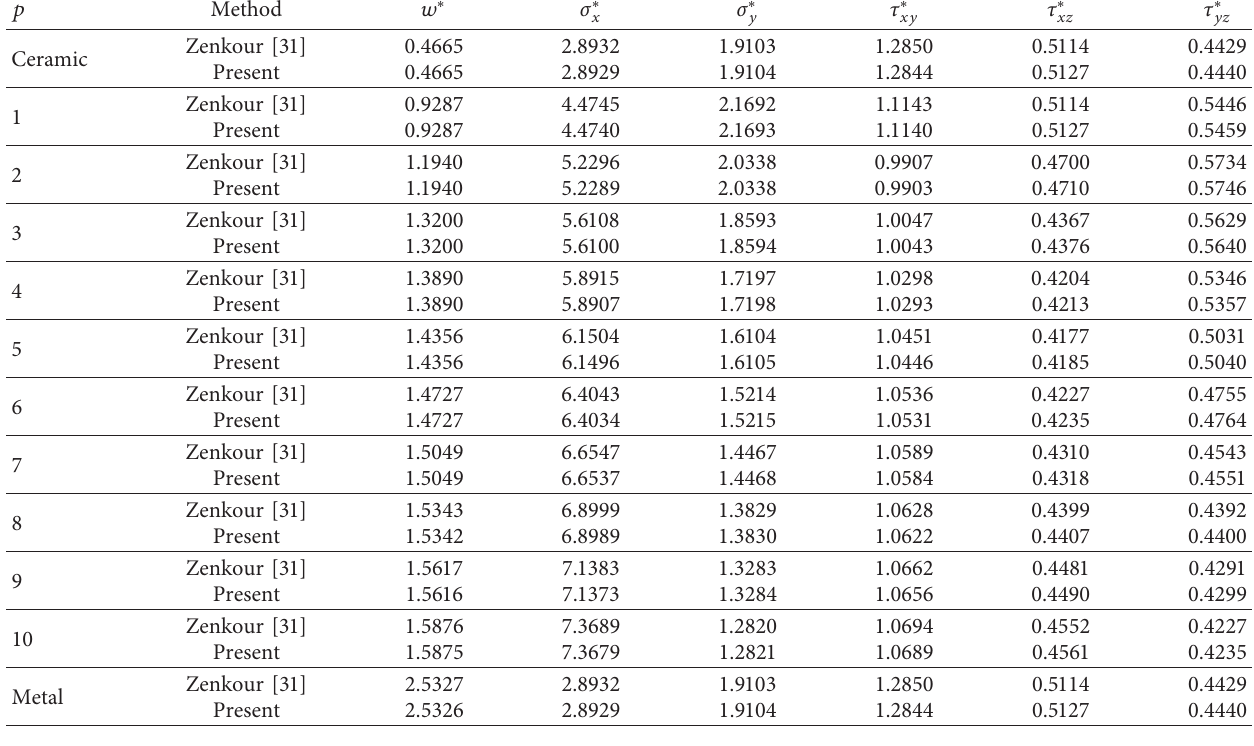
Table 1: The deflections and stresses of the square isotropic FGM plates without elastic